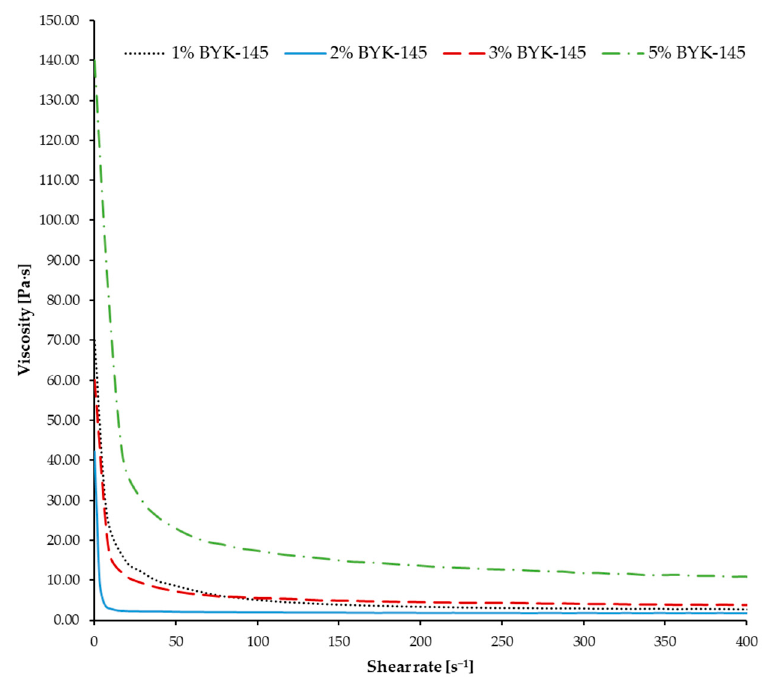
Figure 6. Viscosity vs. shear rate of slurries with BYK-145 at different weight contents. As can be observed, initially the viscosity of the slurry slightly decreased when increasing the dispersant content from 1 wt.% to 2 wt.%, and it reached a stable value at smaller shear rates, which is the desired behaviour. However, if the content was increased to 3 wt.% or 5 wt.%, the viscosity values in the workability window of Admaflex130 in- creased. Therefore, the stability of the slurry is degraded if the dispersant concentration is too high [21]. Al 2 O 3 particles are not efficiently modified by the dispersant when the con- centration is extremely low; however, when its concentration was appropriately raised to 2 wt.%, the particles’ surface covering is more efficient, resulting in a more stable network of particles [52]. However, at higher concentrations, there is a surplus of dispersant, which promotes flocculation and, hence, increases the viscosity. Afterwards, the role of the solid loading was examined; the rheology of the various slurries is reported in Figure 7. As expected, the 70 wt.% solid-loaded slurry exhibited a less viscous behaviour, which resulted in a more liquid slurry being unable to remain within the reservoir during the DLP printing and moved via the tape-casting foil system of Admaflex130 without spilling out. This was due to the extremely low viscosity (<1 Pa·s in the window of interest). On the contrary, the 80 wt.% loading resulted in a more viscous slurry than the 85 wt.% loaded slurry at lower shear rates, and slightly less viscous at higher shear rates. It is possible that the quantity of the dispersant was not optimal for the former, so the particles were flocculating at lower shear rates; however, as higher percent- ages of solid loading facilitate the densification of the finished samples while reducing the shrinkage and, hence, the insurgence of cracks due to the geometrical modifications, the 85 wt.% was preferred as it also showed better properties without further studies. The 90 wt.% solid-loaded slurry was also prepared, even though it was expected that increasing the packing fraction would have rapidly increased the suspension viscosity [53]. In fact, its consistency was more similar to a powder rather than a slurry, even after long mixing and varying the percentage of dispersant. This was essentially due to the reduction of the average distance between the ceramic particles when the solid loading was increased; as a consequence, a relevant increase in the friction between them resulted in a higher vis- cosity [54]. Therefore, it was concluded that such a high solid loading was not viable and the 85 wt.% solid-loaded slurry was selected for the continuation of the study.